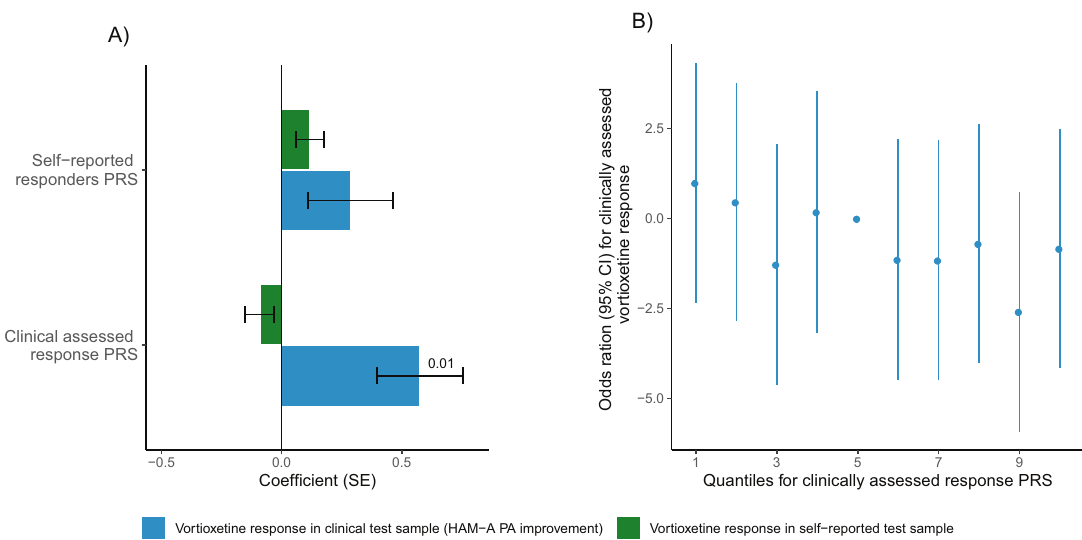
Fig. 2 Treatment response PRSs association with vortioxetine response. A Bar plot showing the coef fi cients of self-reported responders PRS and clinically assessed response PRS association with vortioxetine response in the clinical and self-reported test samples. B Odds ratios for vortioxetine response given by HAM-A PA improvement in the clinical test sample for different quantiles of clinically assessed response